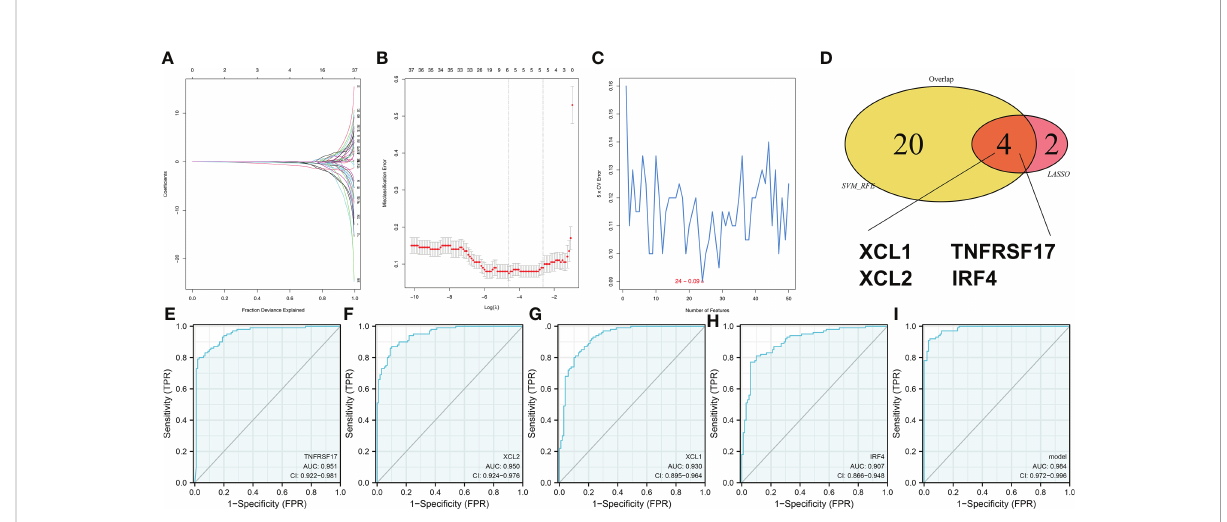
FIGURE 7 Identi fi cationof the characteristic gene of our model (A, B) LASSO logisticregressionwas used to identify the characteristicgenes. (C) The SVM-RFE algorithm was usedto identify the characteristic genes. (D) LASSOlogisticregressionand SVM-RFE intersected four genes, including XCL1 , XCL2 , TNFRSF17 , and IRF4 . (E – H) The ROC curve was performed to evaluate the predictionef fi ciency of the characteristic gene in risk group. (I) Logistics regressionwas performed tocalculate the combined score, which had excellent predictive powerin patients ’ risk group classi fi